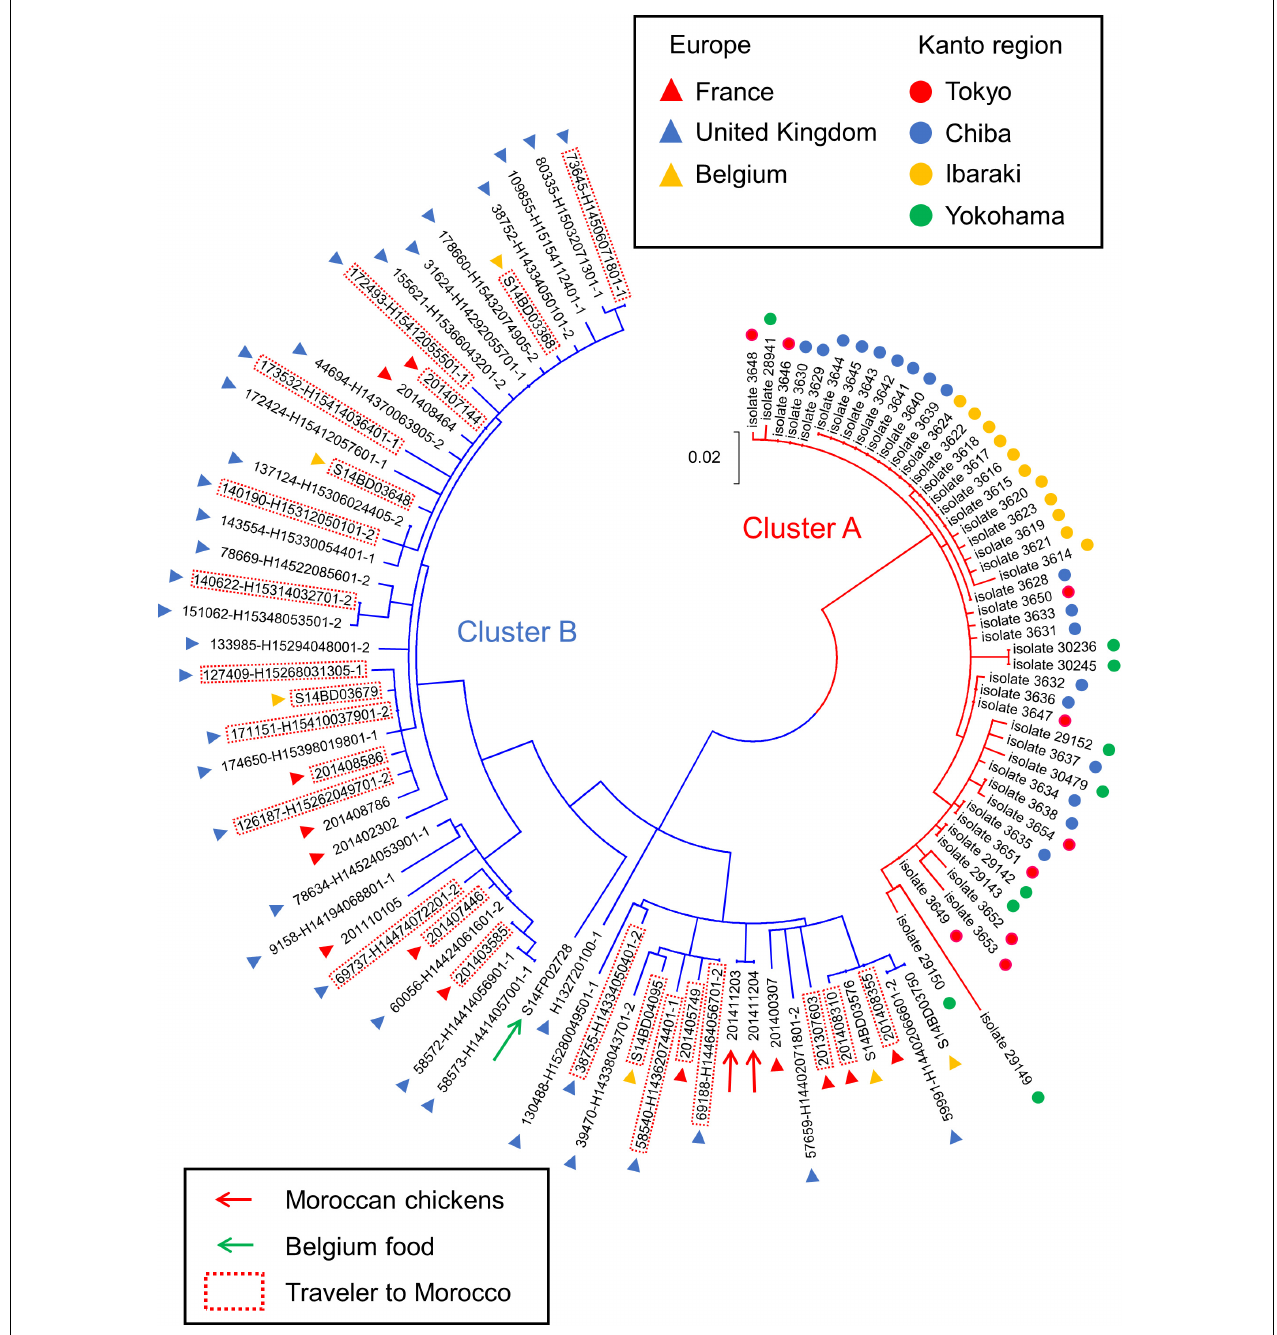
FIGURE 1 | Dendrogram reconstructed from SNPs from Salmonella Chester isolated in the Kanto region of Japan and Europe. Branches for the isolates included in clusters A and B are indicated in red and blue, respectively. Countries and areas where the isolates were collected are indicated by colored circles and triangles. Isolates derived from travelers to Morocco are surrounded by red dotted lines. Red and green arrows show the isolates obtained from chickens or food, respectively. The scale bar indicates the genetic